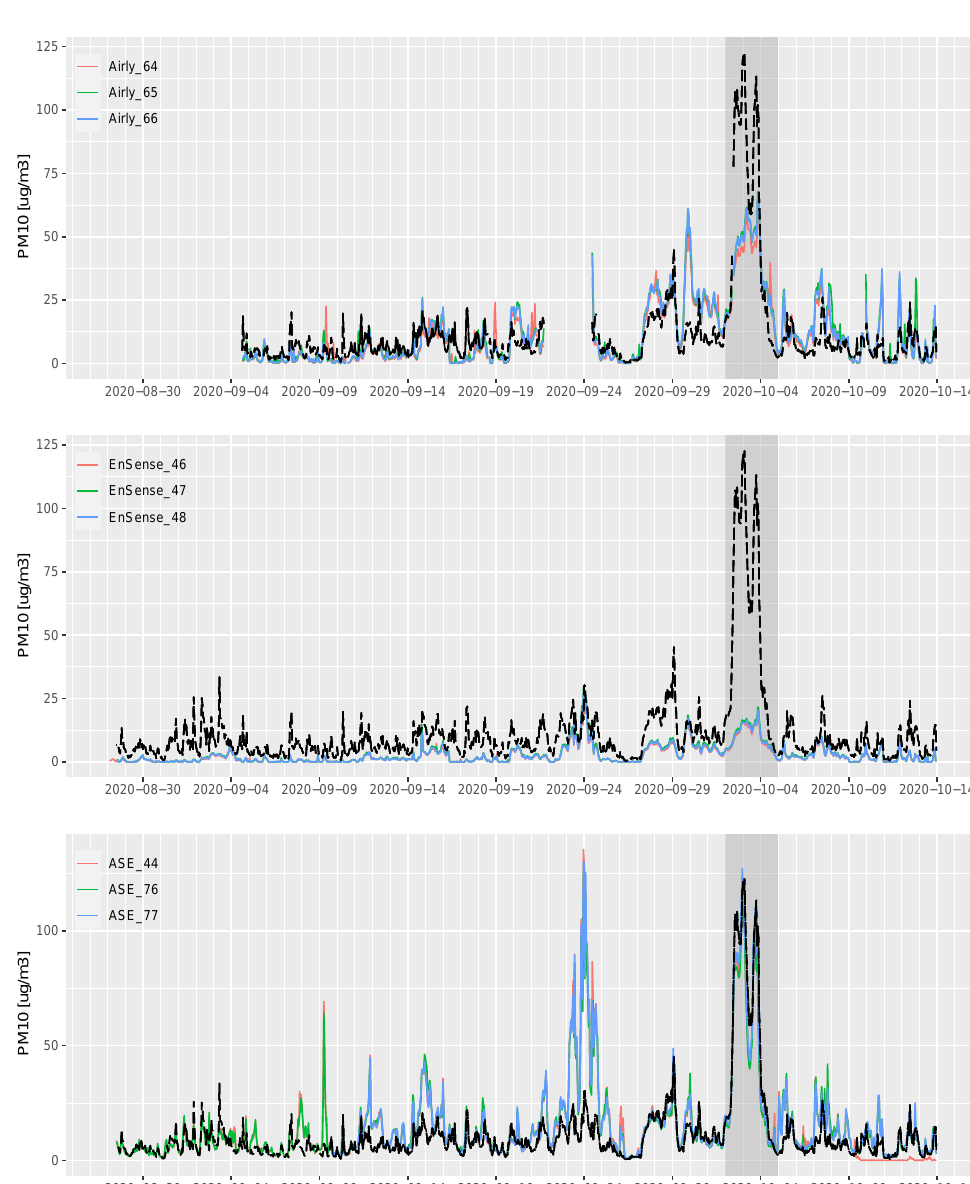
Figure 4. Time series of the factory-calibrated PM 10 signal of all sensors systems. The dashed black line shows the reference data from the Fidas. The top panel shows the Airly sensors, the center panel the EnSense sensors, and the lower panel the AirSensEUR (ASE) sensors. Note that the y-axis range varies from panel to panel for clarity. The dark gray box indicates a pollution episode resulting from long-range